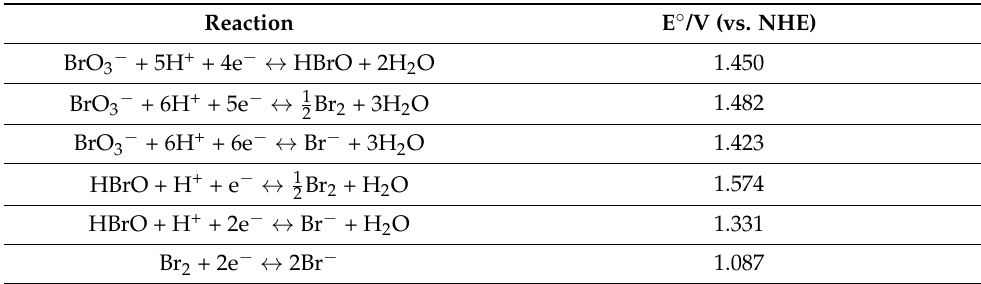
Table 1. Standard potentials (E ◦ )